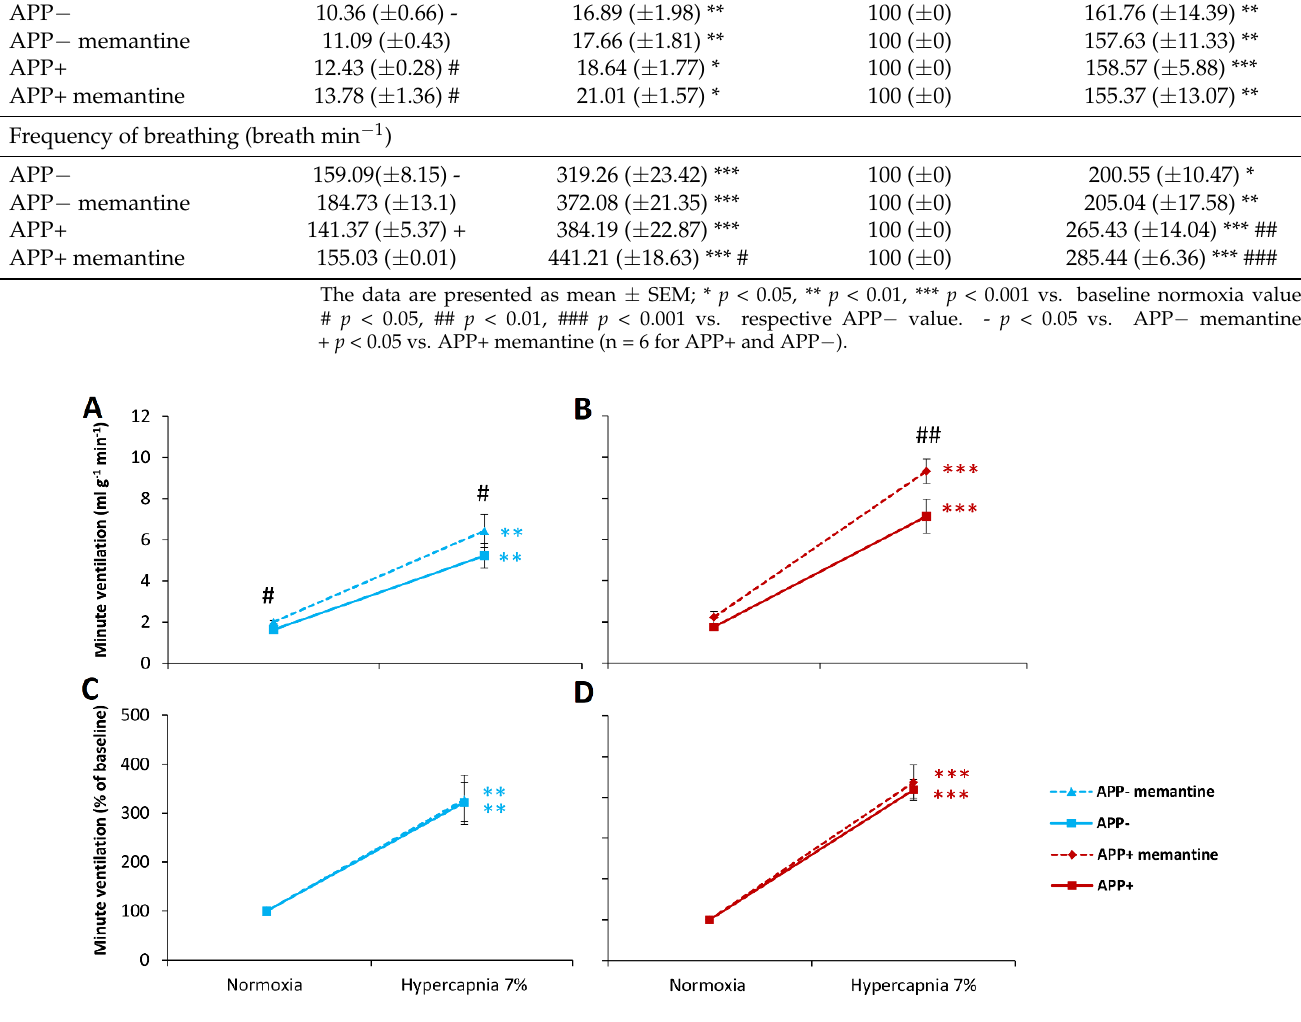
Figure 3. Minute ventilation (V E ) during air breathing (normoxia) and ventilatory response to hypercapnia in APP+ (red line) and APP − mice (blue line) before (solid line) and after meman- tine injection (dashed line) ( A , B ). Minute ventilation expressed as a percentage of baseline (nor- moxia) values ( C , D ). Note the lack of difference in hypercapnia reactivity in the two groups of mice. The data are presented as mean ± SEM, ** p < 0.01, *** p < 0.001 vs. normoxia value, # p < 0.05. ## p < 0.01 vs. pre-memantine state (n = 6 for APP+ and APP −